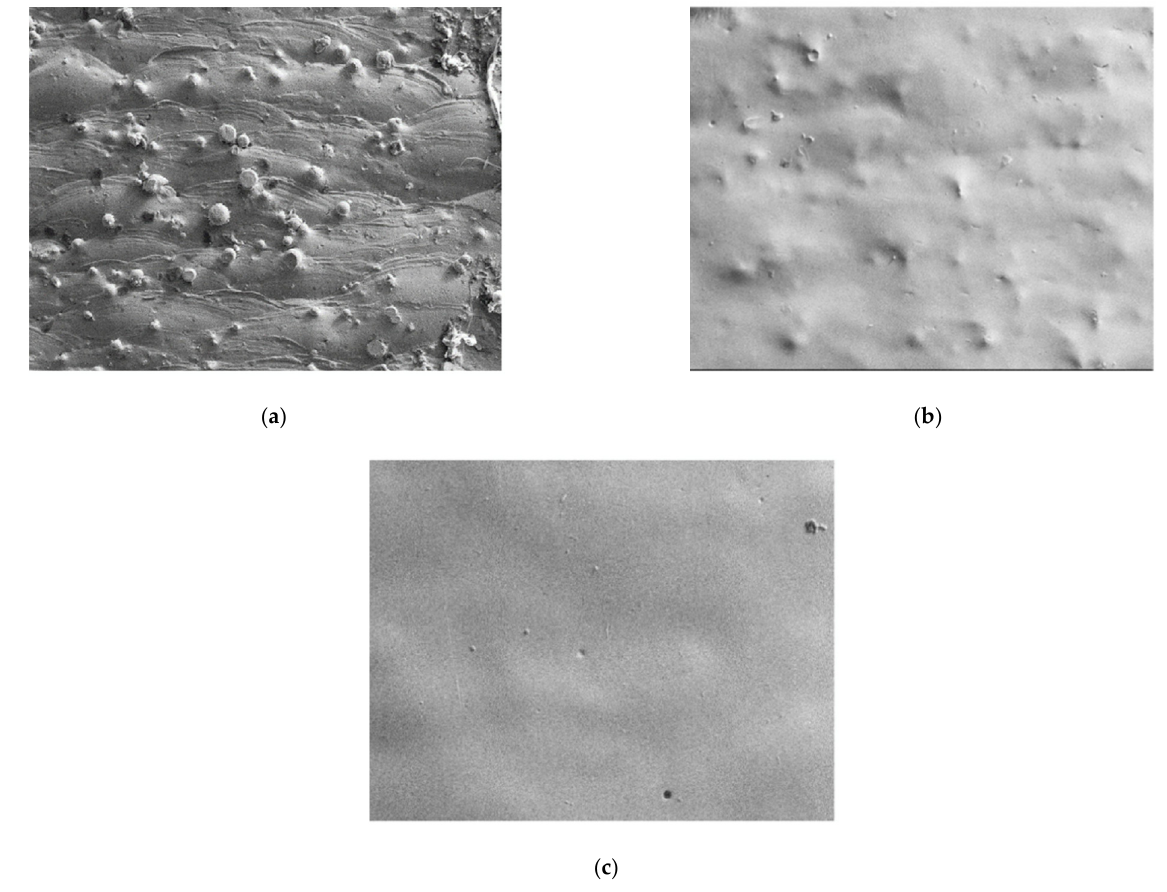
Figure 18. Surface of the part: ( a ) prior to finishing; ( b ) 2 min; ( c ) 5 min after EC finishing [67]. Zhao et al. [68] studied how the internal surface can be finished using the electro- chemical process. In their work, they studied how different current densities affect the machining performance in the mixture of salt and water. The finishing time was adjusted so that the total charge received was the same in all cases. It was found that the current density of 2 A/cm 2 was not enough to remove all the powders and no further effect was observed, even when the finishing time was increased. On the other hand, a current density of 7 A/cm 2 , along with a finishing time of 2.86 min, was enough to remove the un-melted powders. The surface of the AM part had an arc-shaped texture due to the SLM process. The roughness (Sa) of the part was reduced from 15.552 to 8.102 µ m. Urlea and Brailovski [69] studied how the electrochemical polishing inside perchloric and glacial acid solution is accomplished. By using trial tests, they observed that polishing occurs at higher voltages and current density values. After optimizing the current density and the voltage, electrochemical finishing was performed on the surface with a varied built angle. The maximum reduction in surface roughness (Ra) was obtained for 112.5 and 67.5 degrees and equal to 94%. The final roughness on these surfaces was less than 1 µ m and the maximum surface roughness did not exceed 4 µ m for all the experiments. One of the major issues related to electrochemical polishing is pit formation. Due to the mass movement in the solution, gas bubbles can be formed. Such bubbles can form non- conductive layers by sticking to the workpiece and can explode when the current density increases, leading to pit formation [70]. According to Basha et al., this issue can be mitigated by applying magnetic field stirring